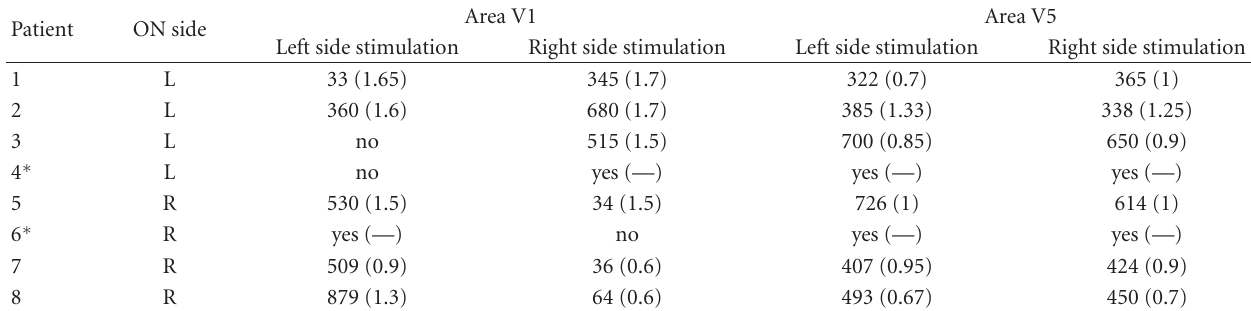
Table 2: Voxel number (and percent BOLD signal increase) of the activation foci elicited in areas V1 and V5 during stimulation of the a ff ected and una ff ected eye.